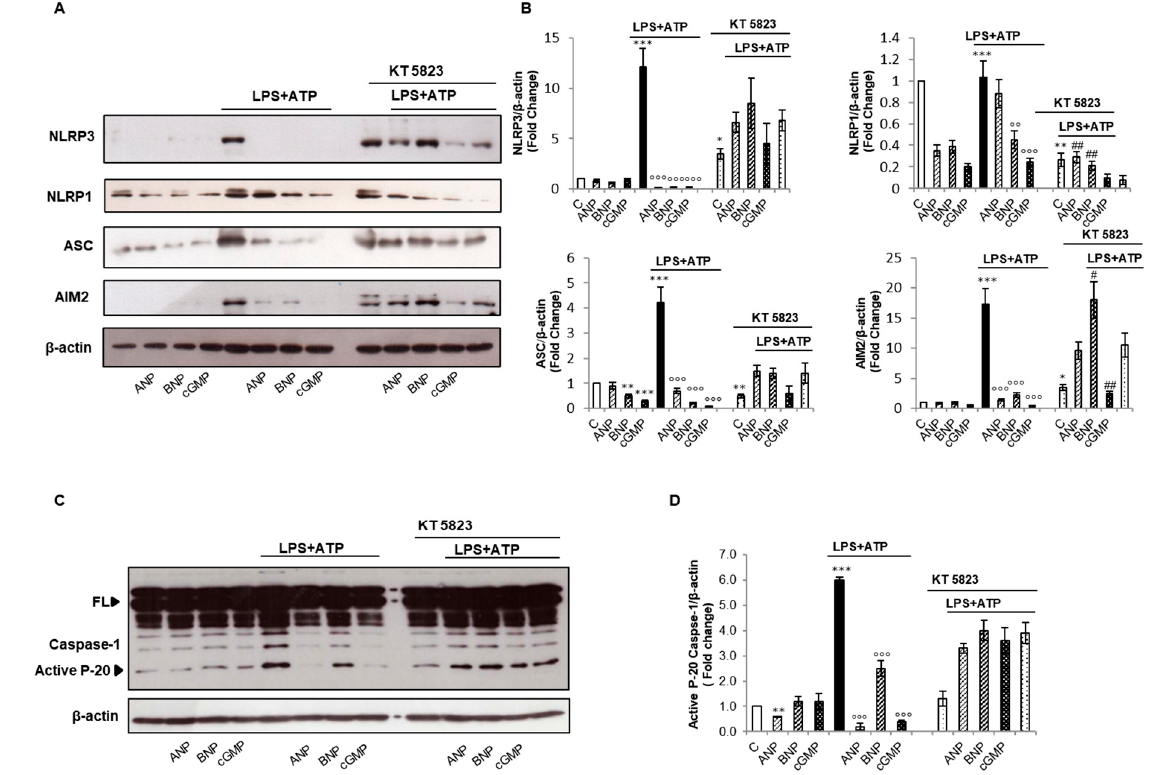
Figure 3. cGMP/PKG-I axis is involved in the activation step of IL-1 β maturation. THP-1 cells were pre-treated for 10 min with ANP (10 − 8 M) or BNP (10 − 8 M) or cGMP (100 µ M 8-Br-cGMP) in the absence or presence of LPS (10 µ g/mL for 20 min) + ATP (5 mM for 40 min). When KT-5823 (1 µ M) was used, it was added 1 h before ANP, BNP, or 8-Br-cGMP treatment. Cell lysates were immunoblotted for NLRP3, NLRP1, ASC, AIM2 ( A ) or Caspase-1 ( C ). The blots were stripped and re-probed with mouse anti- β -actin to confirm equal loading. Representative western blots images are shown. ( B , D ) Histograms of densitometric quantification. Bars represent the ratio between respective protein and β -actin band intensity. Untreated cells were used as control and assumed as 1. The histogram indicates mean ± SD of at least n = three independent experiments, each one tested in triplicate. * p < 0.05, ** p < 0.01, *** p < 0.001 versus untreated cells; ◦◦ p < 0.01, ◦◦◦ p < 0.001 versus LPS + ATP treated cells; # p < 0.05 and ## p < 0.01 versus KT-5823 + LPS + ATP treated cells.